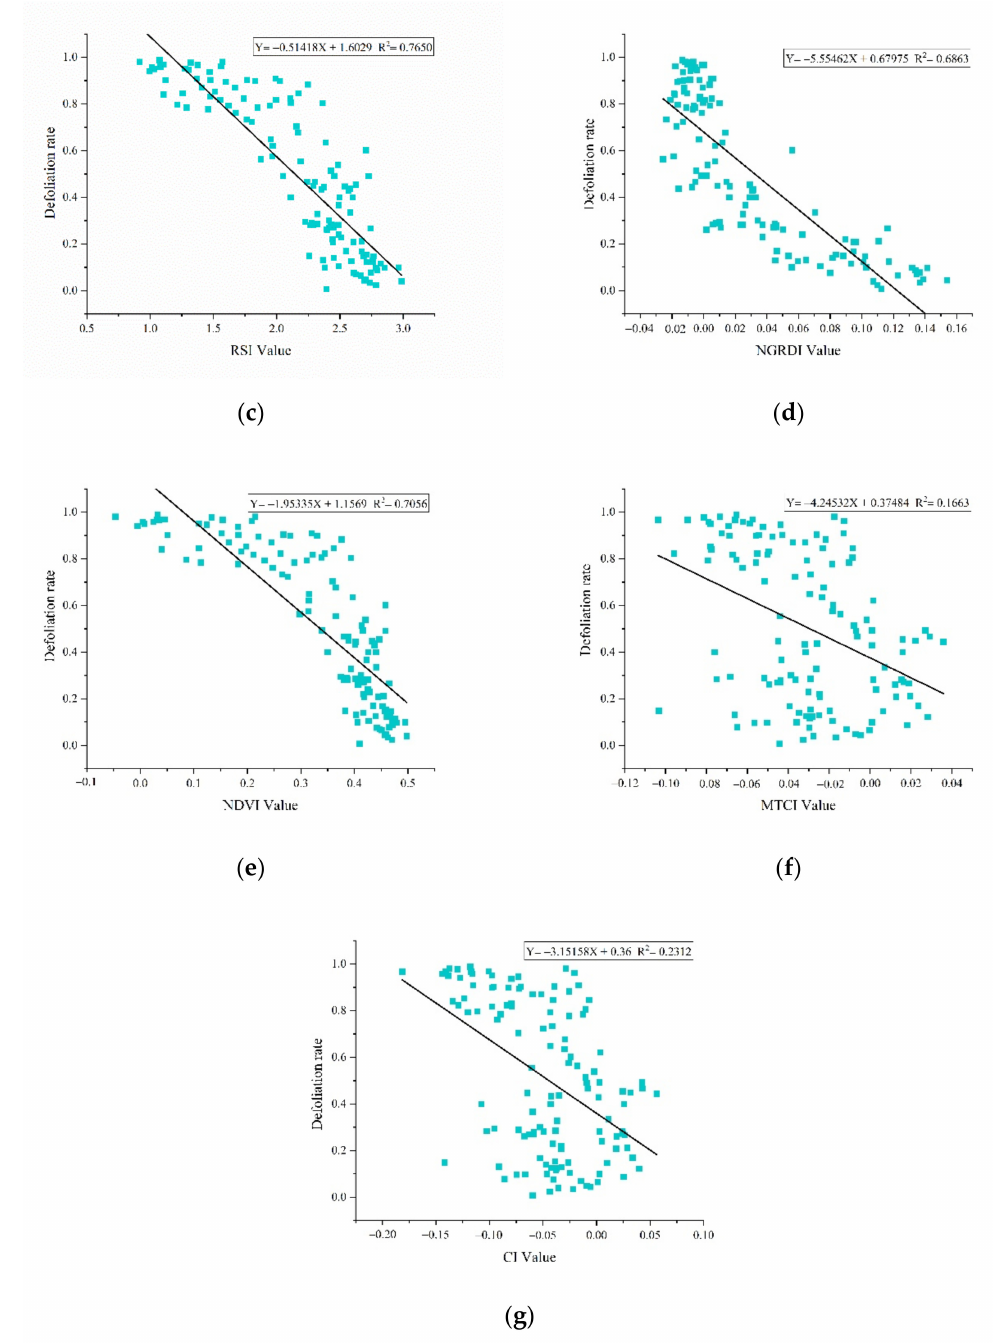
Figure 5. Linear fitting results of vegetation index and defoliation rate results. ( a ) VARI; ( b ) VDVI;